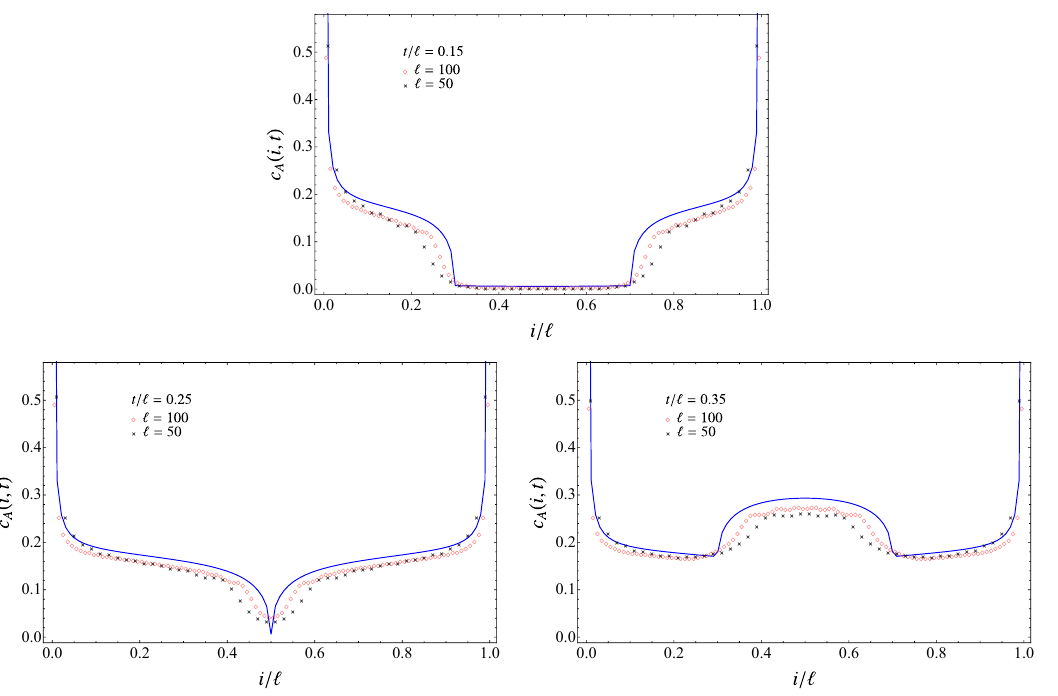
Figure 11 . Temporal evolution of the contour of the capacity of entanglement of an interval made by ‘ sites after the mass quench in the infinite harmonic chain. In the quench considered ω 0 = 1 and ω = 0 . The quasi-particle formula provides the solid lines in all the